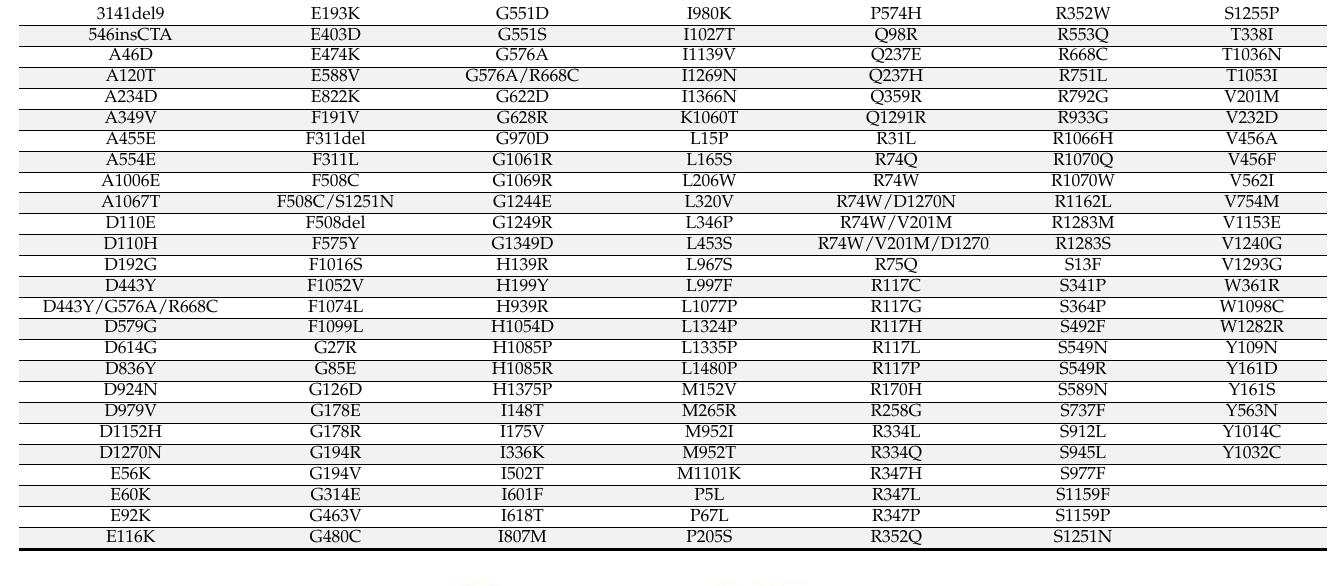
Table 4. List of CFTR mutations eligible for the treatment with Ivacaftor/Tezacaftor/Elexacaftor and approved by the FDA. Patients should carry at least one copy of the mutations listed here. Available from https://www.vertexgps.com, accessed on 14 November 2022.